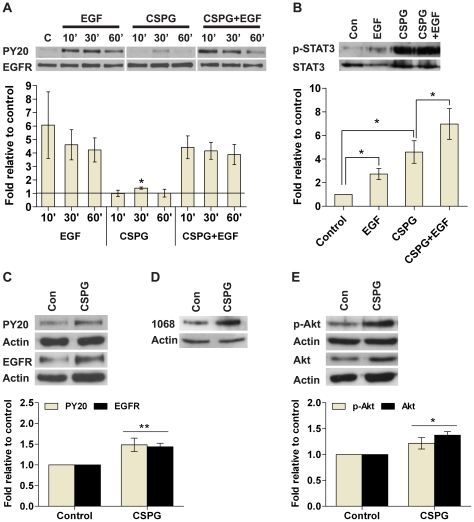
CSPG stimulates EGFR signaling pathways.Kinase activity was estimated by using Western analysis. Whole cell lysates were separated by SDS-PAGE and probed with phosphotyrosine antibodies; PY20, p-Akt, p-EGFR (1068), and p-STAT3. The respective total protein signal was used to normalize protein loading. For each figure, the images are representative Western blots while the bar charts below show quantification of signals expressed relative to control. Data are presented as mean ± SEM with n≥4 (from ≥3 experiments); * P≤0.05, ** P≤0.01 compared to control (con) or as indicated on the graphs. (A) Nsphs were dissociated into single cells and cultured in growth medium without EGF for three hours followed by stimulation with EGF (20 ng/ml), CSPG (50 µg/ml) or both for 10 to 60 min. EGFR activation status as seen by PY20. (B) Cells were cultured as in (A) followed by stimulation with EGF (20 ng/ml) for 30 min or CSPG (50 µg/ml) for three hours. Cells pretreated with CSPG (50 µg/ml) for three hours were stimulated with EGF (20 ng/ml) for 30 min (CSPG + EGF). STAT3 activation status as seen by p-STAT3. (C) Cells were cultured for six days in the presence of EGF (20 ng/ml), with or without CSPG (50 µg/ml). EGFR activation status as seen by PY20 and EGFR levels. (D) Cells were cultured as in (C) and EGFR phosphorylation at tyrosine residue 1068 was evaluated using the p-EGFR (1068) antibody. (E) Cells were cultured as in (C) and Akt activation status as seen by p-Akt and Akt levels.